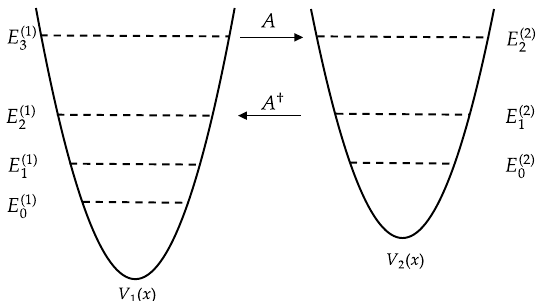
( 1 ) = 0, the other 0